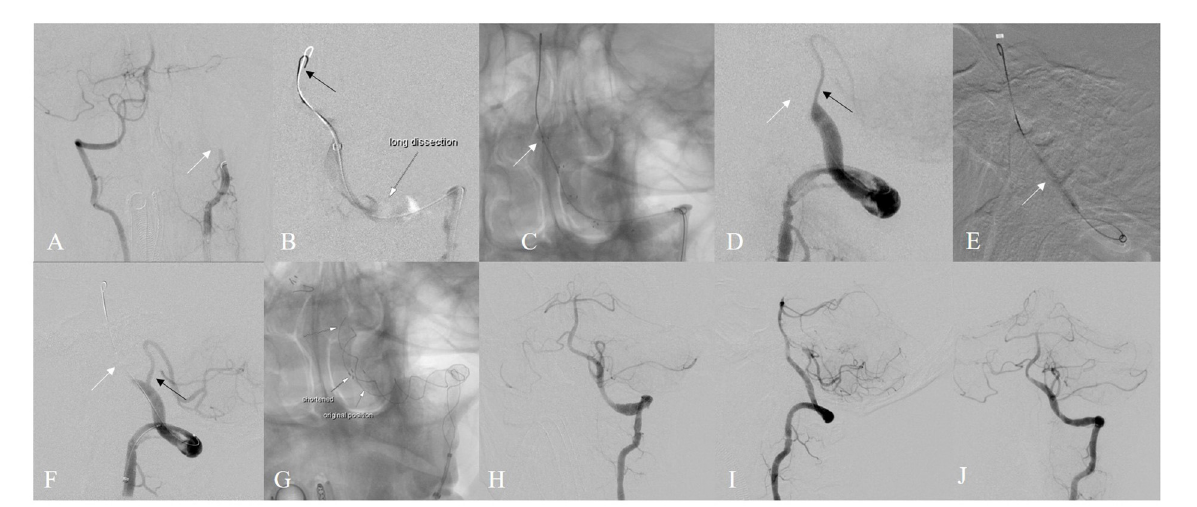
FIGURE2 Illustrative case of “standby microwire technique” (A) left VA was occluded (B) superselection of exchange catheter through long segmental dissection (C) “J” sahpe microwire remained in the dissection (D) after 1st thrombectomy (E) balloon dilation was then used (F)